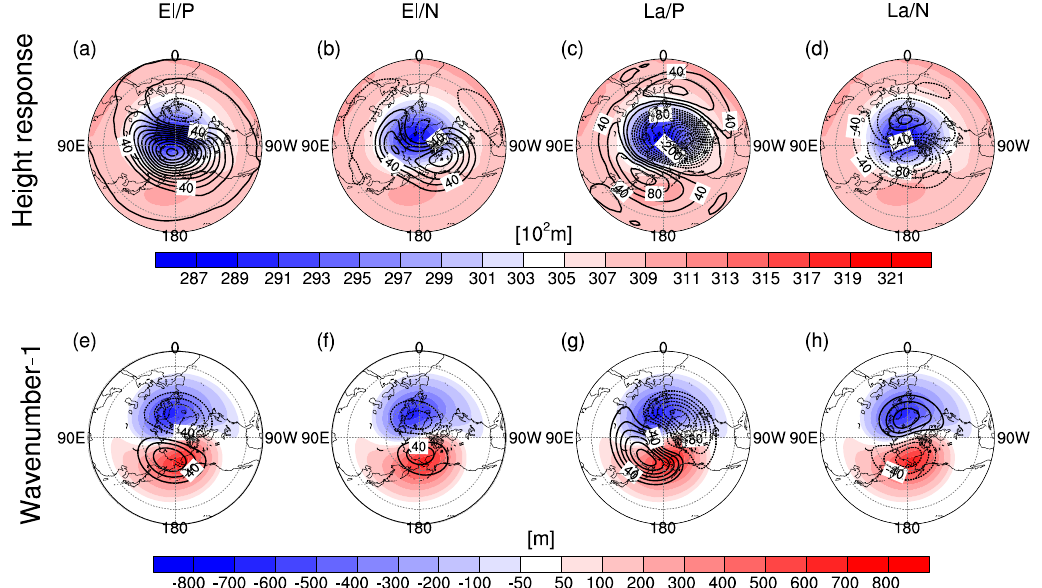
Figure 7. Composite height anomalies at 10 hPa (top row) and the zonal wavenumber–1 components (bottom row) during El Niño winters when the PDO is in its ( a,e ) positive and ( b,f ) negative phases and those during La Niña winters when the PDO is in its ( c,g ) positive and ( d,h ) negative phases (contours; units: gpm; interval: 20; zero lines skipped for clarity). Shadings are the corresponding winter height climatology (units: gpm) at 10hPa.